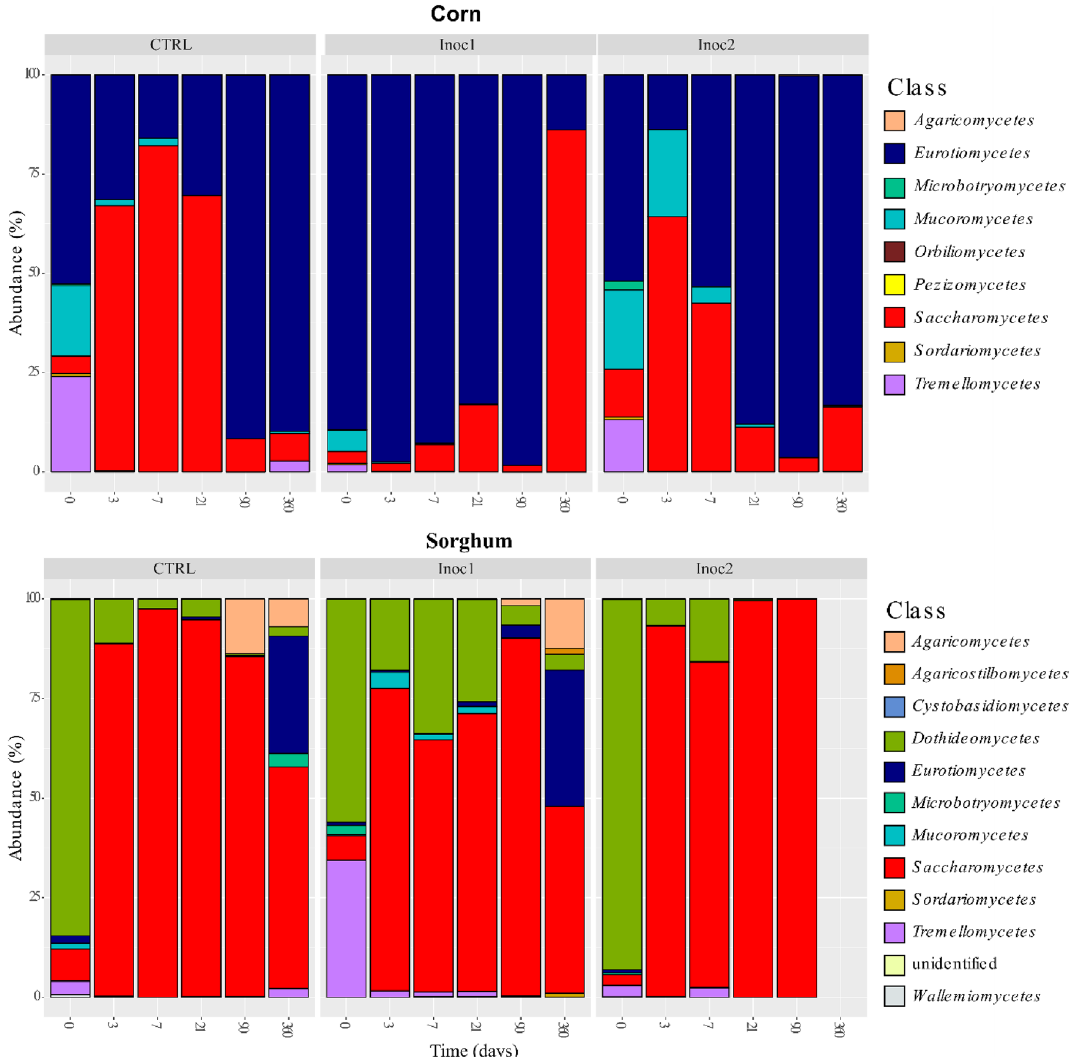
Figure 6. Class taxonomic profiles of fungal communities of rehydrated corn and sorghum grain silages after 0, 3, 7, 21, 90 and 360 days of fermentation. CTR non-inoculated, Inoc1 Lactobacillus plantarum and Propionibacterium acidipropionici , Inoc2 Lactobacillus buchneri